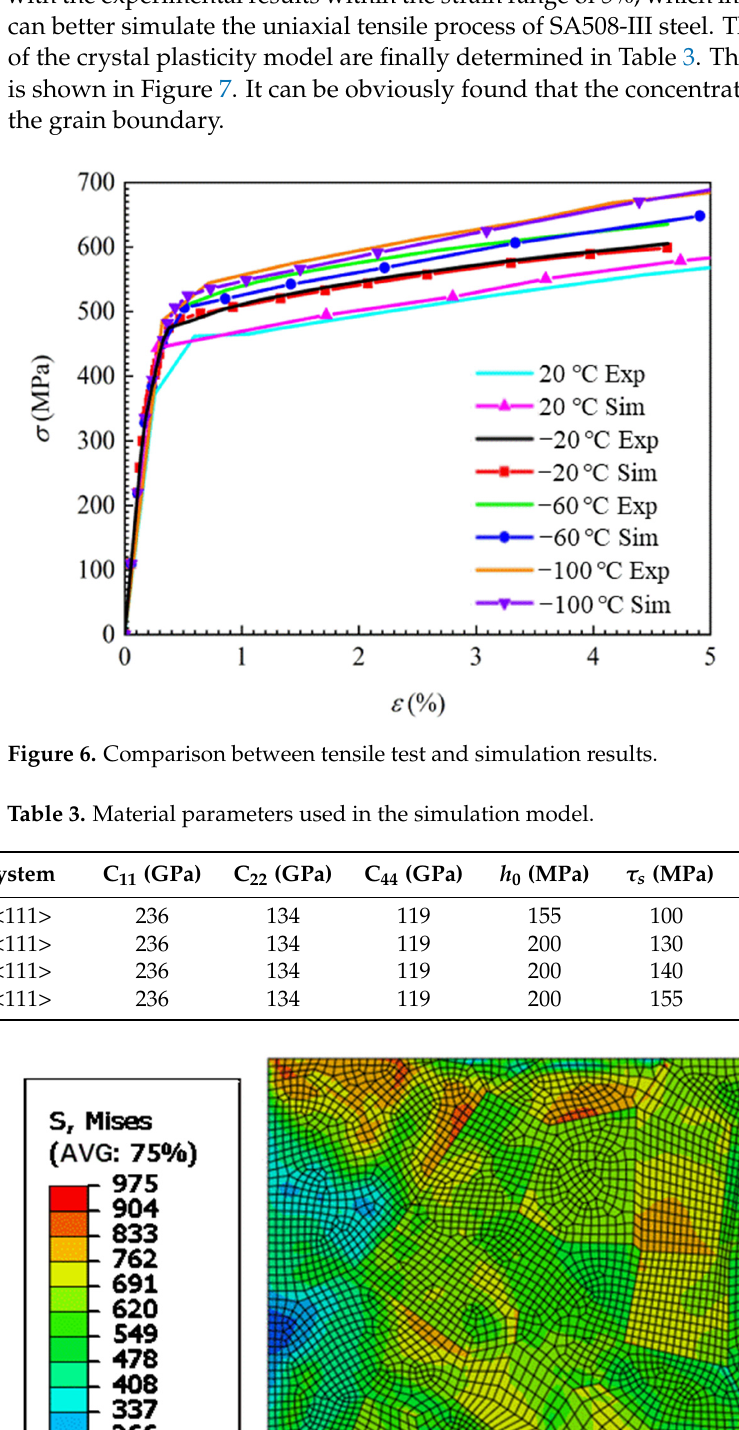
Figure 7. The stress field of the tensile model at − 100 °C . Table 3. Material parameters used in the simulation model.